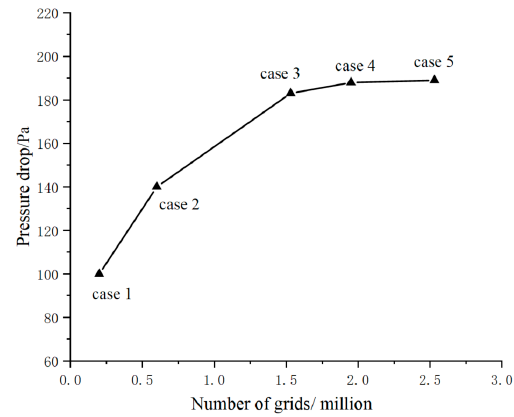
Figure 3. Grid independence verification.